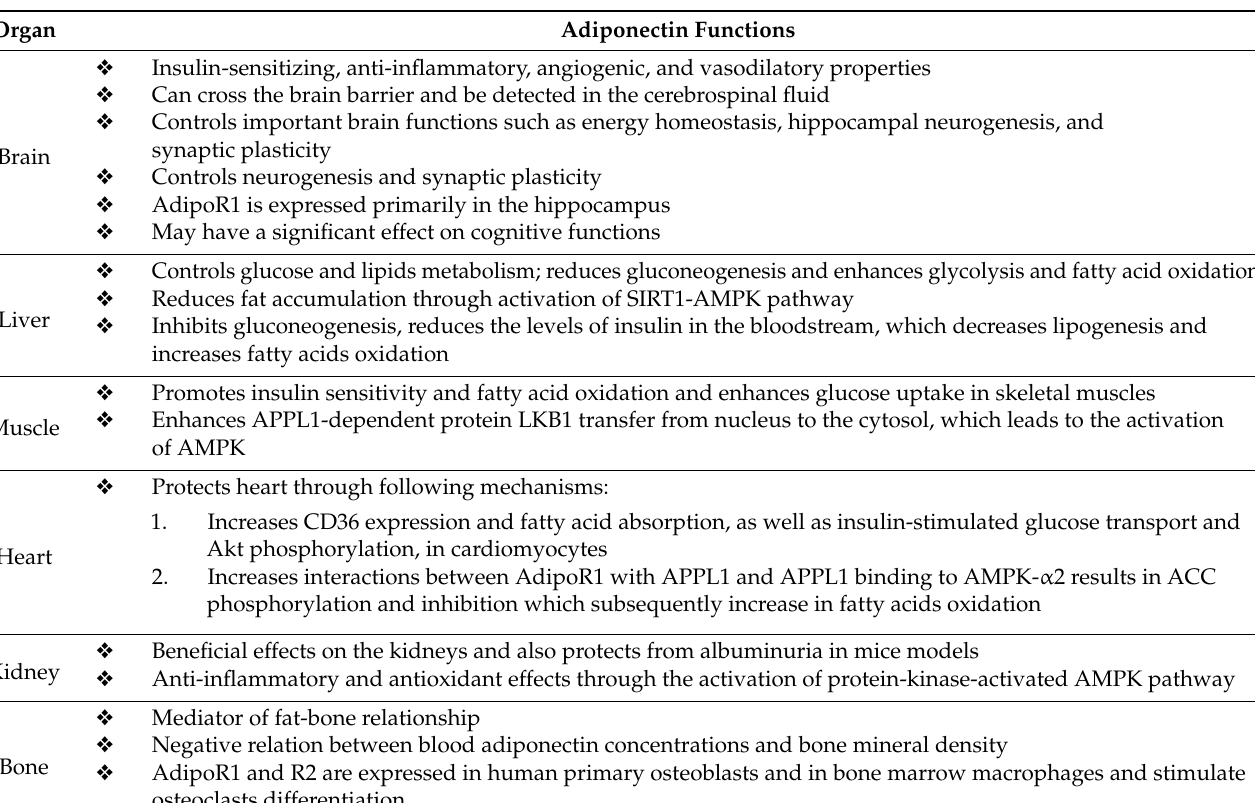
Table 2. Adiponectin functions in different body